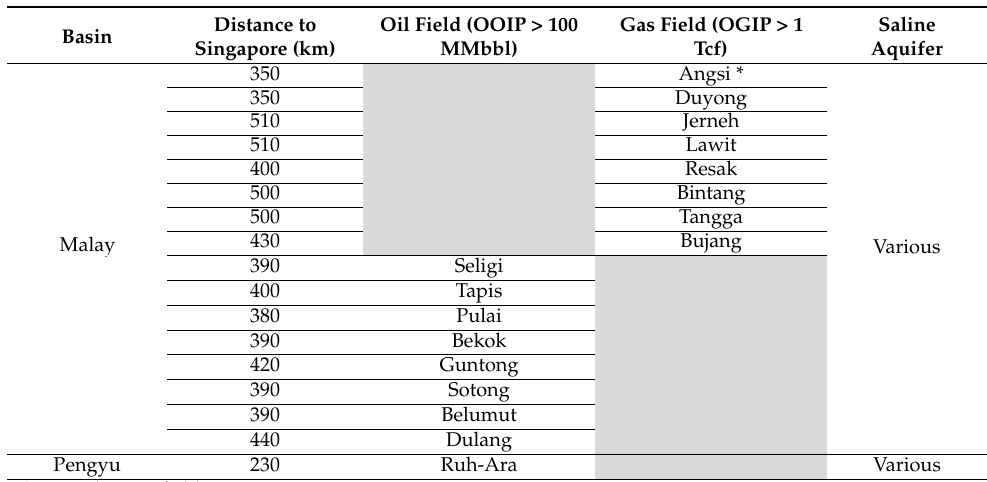
Table 4. Major Malaysian fields within 1000 km from